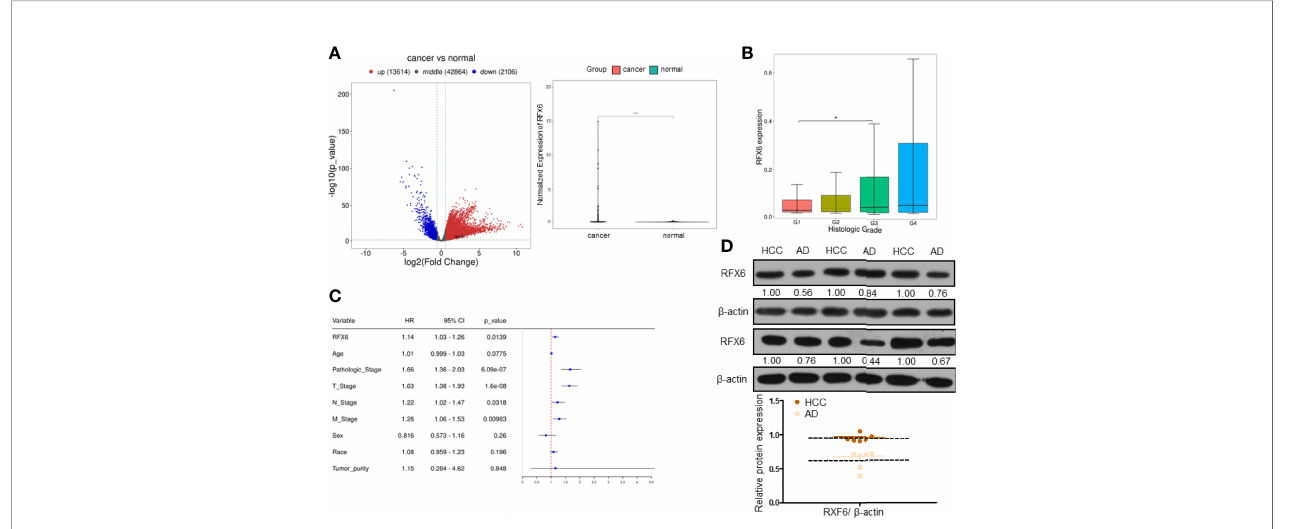
FIGURE 1 | RFX6 is highly expressed in hepatocellular carcinoma and negatively correlated with prognosis. (A) TCGA data analysis of differentially expressed genes in liver hepatocellular carcinoma tissues ( n = 374) compared with adjacent normal tissues ( n = 50) (left panel). The paired comparison of RFX6 in the TCGA database, containing human breast cancers ( n = 50) and tumor adjacent normal tissues ( n = 50) (right panel, * p < 0.05). (B) Wilcoxon test was used to test the difference of RFX6 expression in different groups of clinical data to demonstrate the correlation between RFX6 expression and histologic grade. (C) Multivariate Cox regression analysis of patients based on the expression level of RFX6. (D) The protein levels of RFX6 were higher in liver cancer tissue samples than in adjacent normal tissues (six